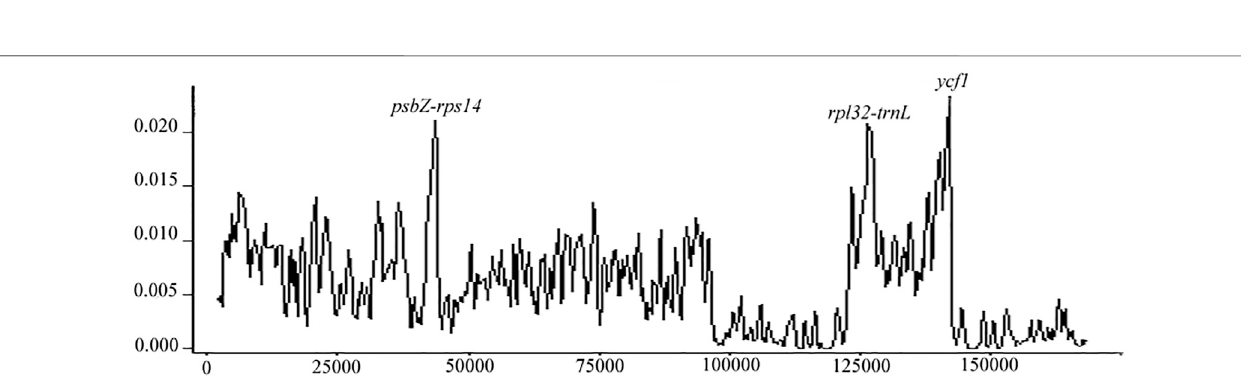
FIGURE 1 | (A) Number of SSRs in the Acer species chloroplast genome. (B) Number of SSRS types of chloroplast genome in 48 Acer species.